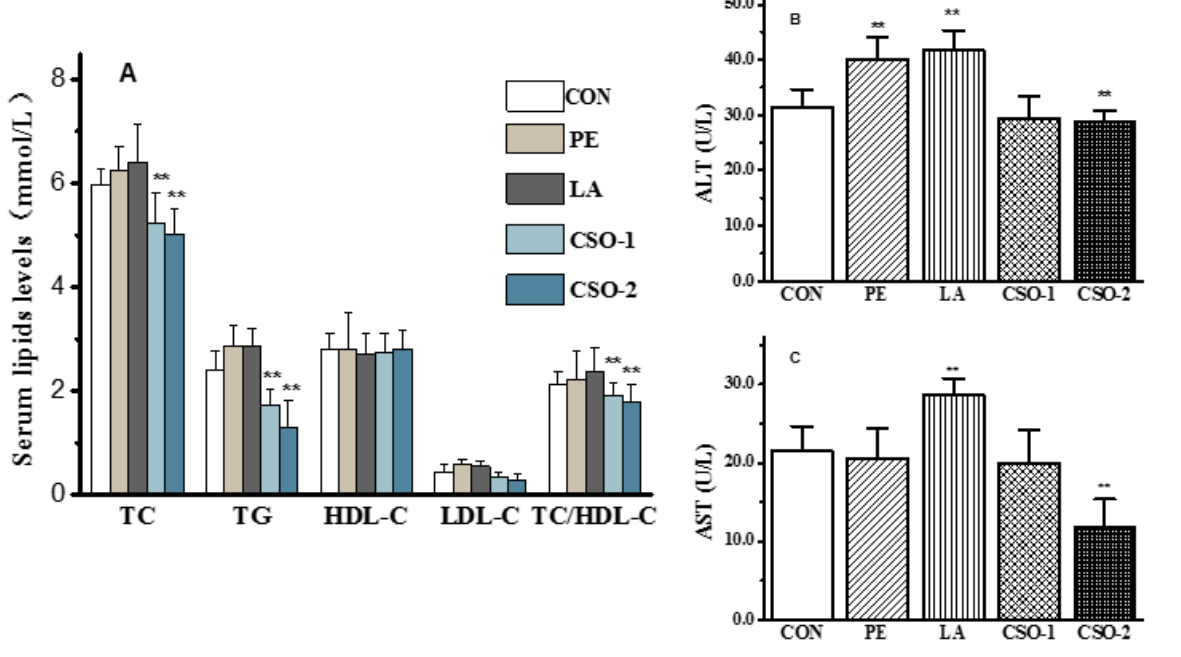
Figure 2. Effects of CSO on plasma lipids contents of HFD-induced obesity mice. ( A ) Serum lipids levels; ( B ) ALT; ( C ) AST. Data presented as means with the standard deviation (SD), p < 0.01 (**) compared to CON group (CON: given normal saline group; PE: peanut oil group; LA: lard group; CSO-1and CSO-2: CSO oral injection groups of 30 mg/kg/BW and 50 mg/kg/BW, respectively).